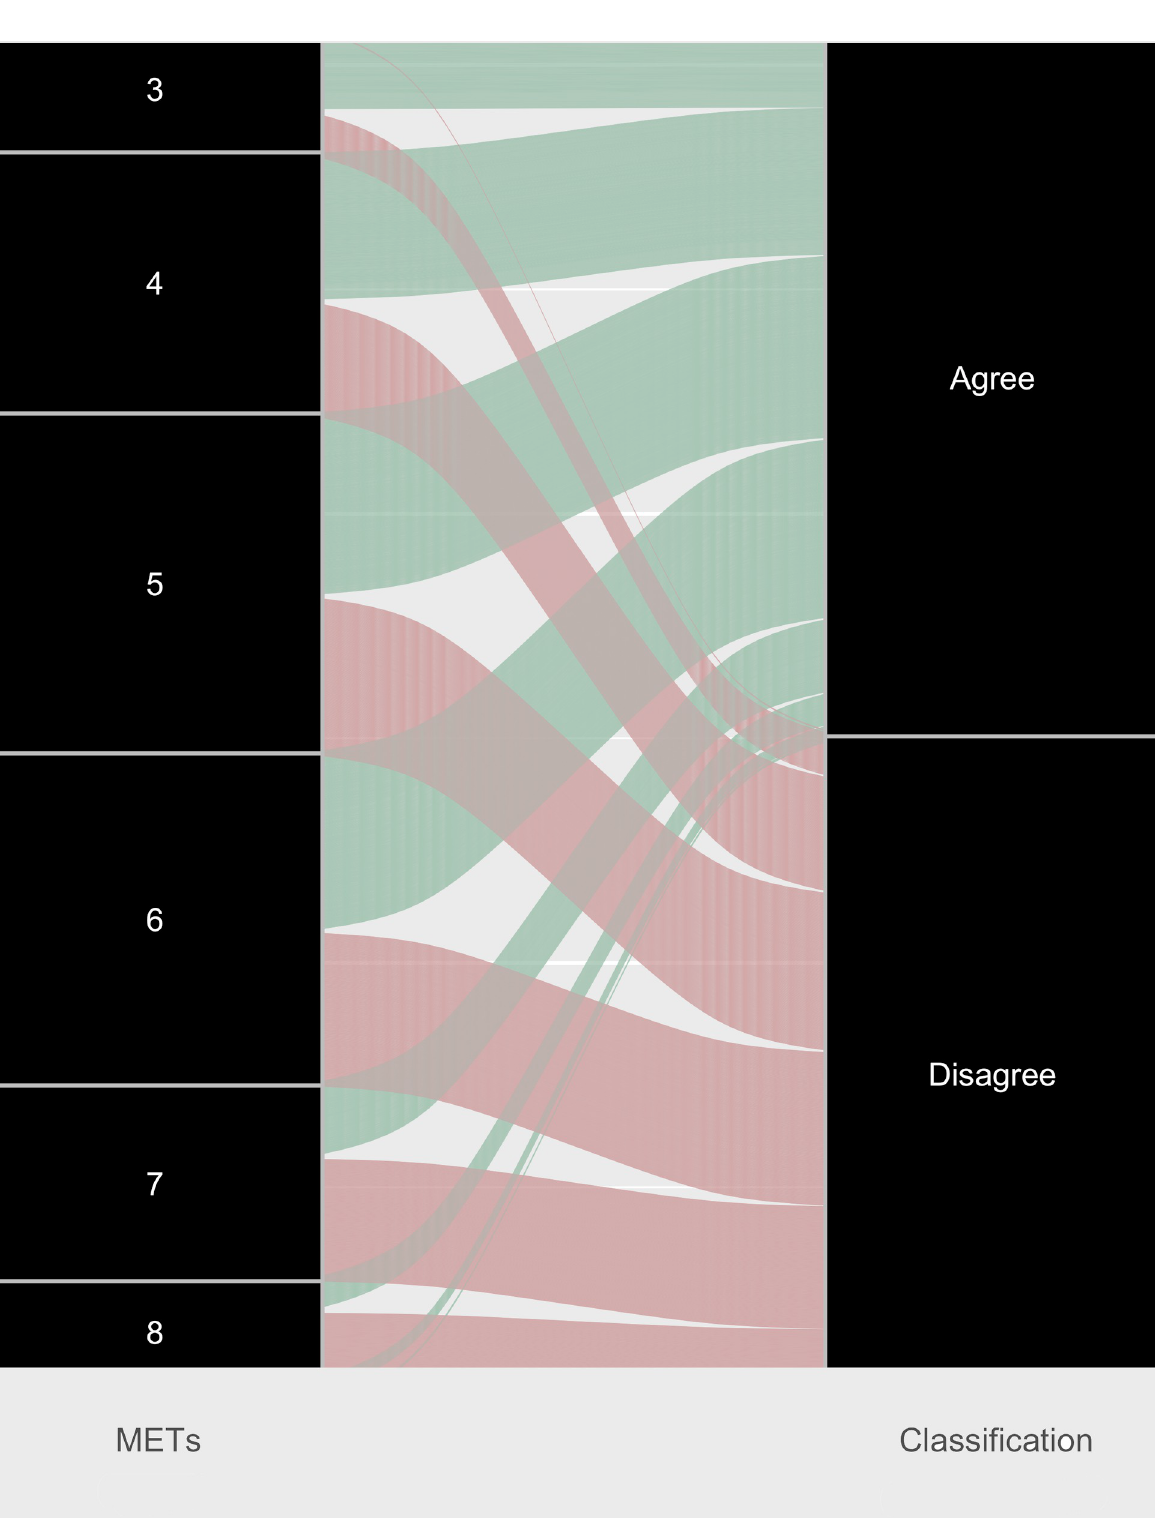
PLOS ONE | https://doi.org/10.1371/journal.pone.0277031 November3,